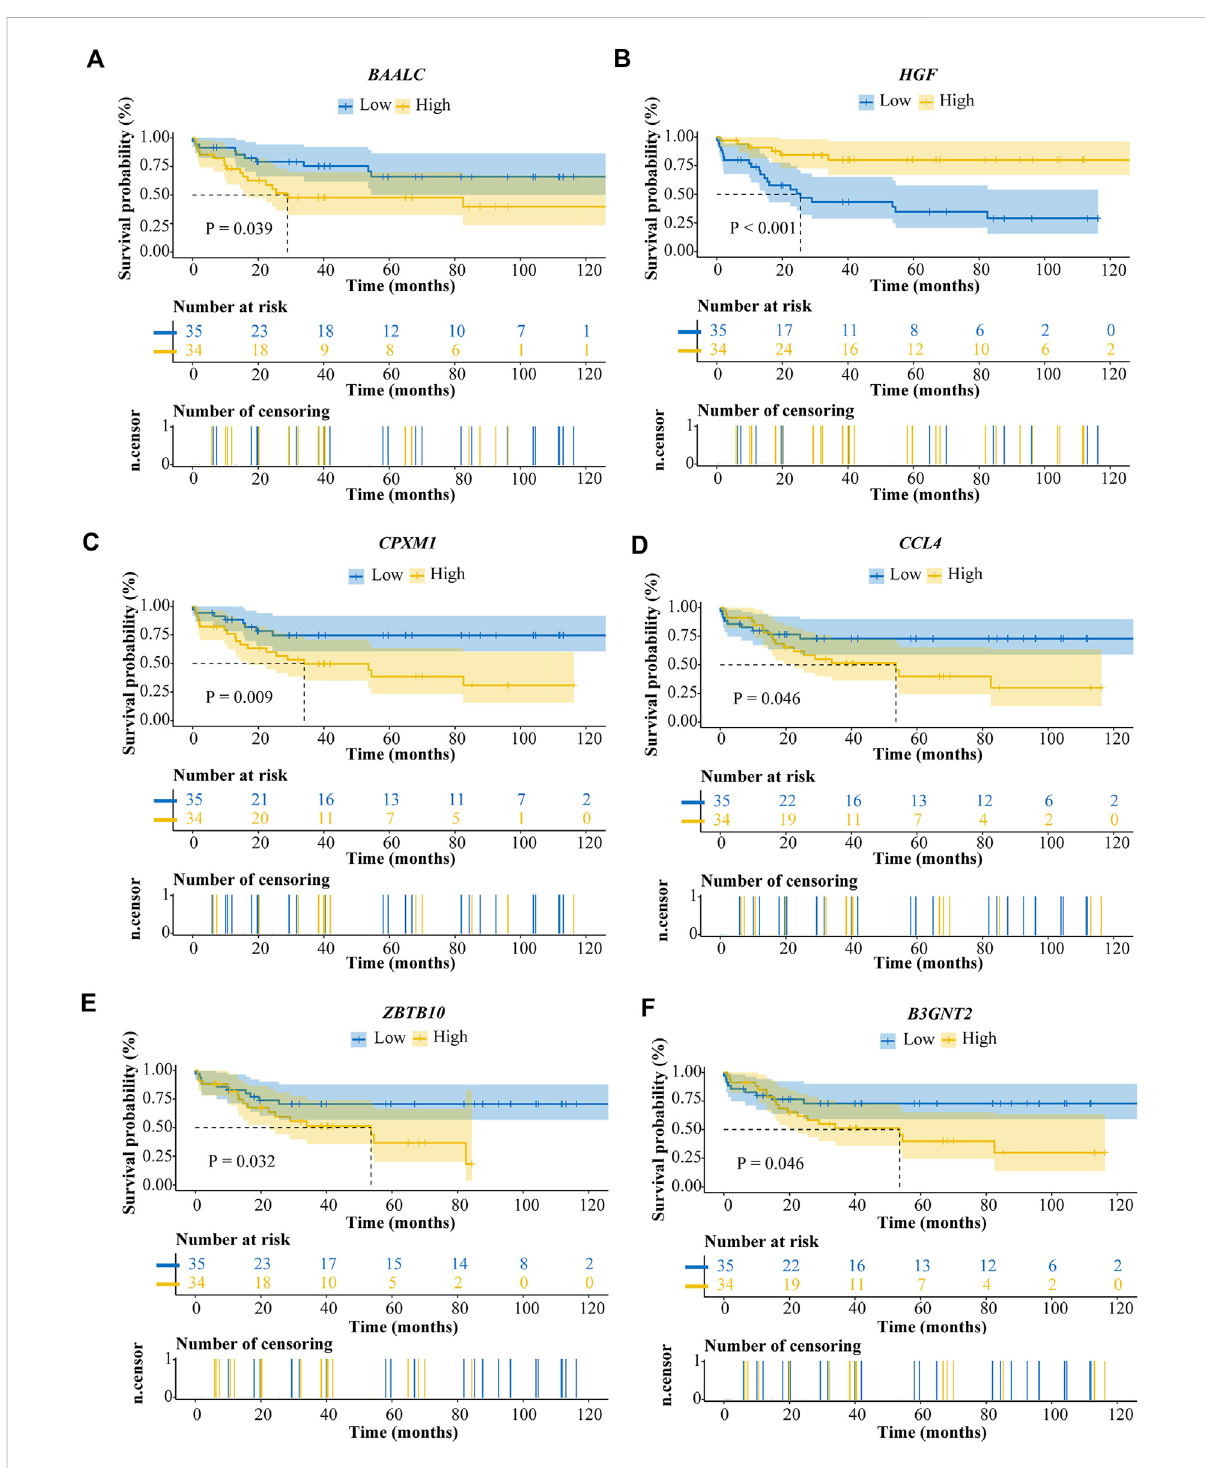
FIGURE 4 Survival analysis of ALL prognostic genes. (A) BAALC . (B) HGF . (C) CPXM1 . (D) CCL4 . (E) ZBTB10 . (F) B3GNT2 .